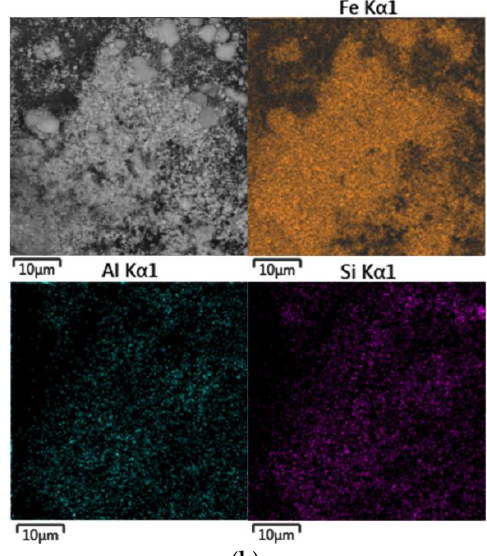
Table 5. The chemical compositions of the solid residues obtained after leaching, wt. % (T = 120 °C, τ = 2.5 h, FeSO 4 -to-BR ratio of 1:1).